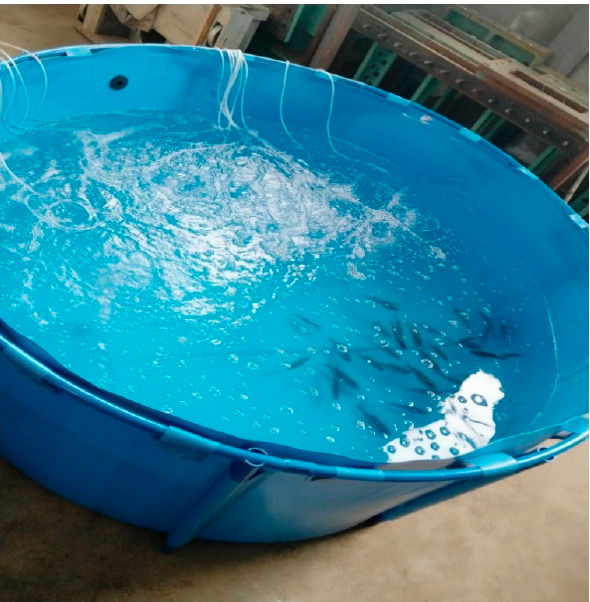
Figure 3. Experimental fish in the temporary storage tank. Table 1. Experimental